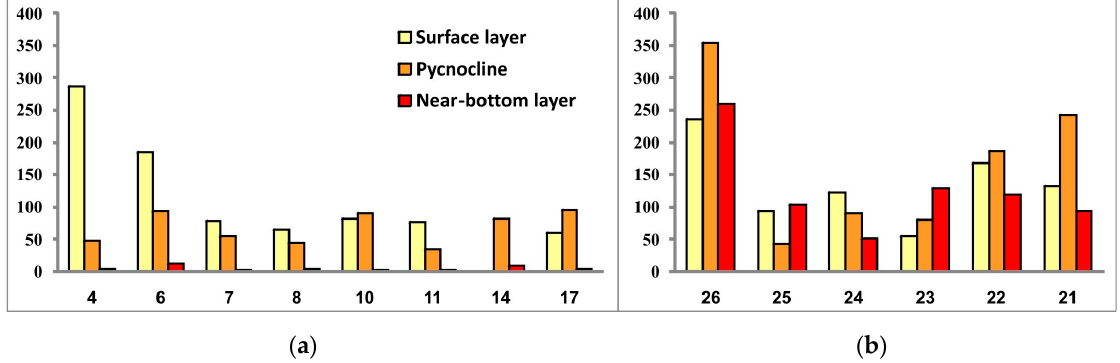
Figure 10. Phytoplankton abundance (thousand cells/L) in the three investigated seawater layers at sampling stations located in the southwestern Kara Sea ( a ) and the southeastern Barents Sea ( b ).